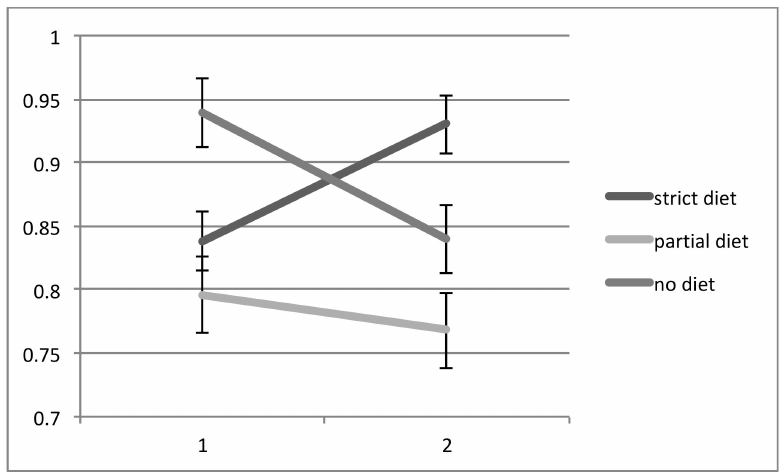
Figure 1. NAA/Cr area ratio in patients with gluten ataxia without enteropathy following the introduction of a gluten-free diet (GFD) in the 2 sub-groups (number of patients on gluten free diet 10, partial diet 5). The third subgroup consisted of 6 patients who declined a GFD. All patients had antigliadin antibodies (AGA) IgG and/or IgA of >3 U/mL and <7 U/mL at baseline. Both the partial diet and no diet groups still had AGA values >3 U/mL at the time of the second scan. All 10 patients on a strict GFD showed improvement of the NAA/Cr area ratio (vertical axis) of the vermis 4 of the 5 patients on partial GFD and all 6 patients not on GFD showed deterioration of the NAA/Cr ratio. A Chi squared contingency table looking at numbers improved on magnetic resonance spectroscopy on a strict diet compared with no diet was significant p <